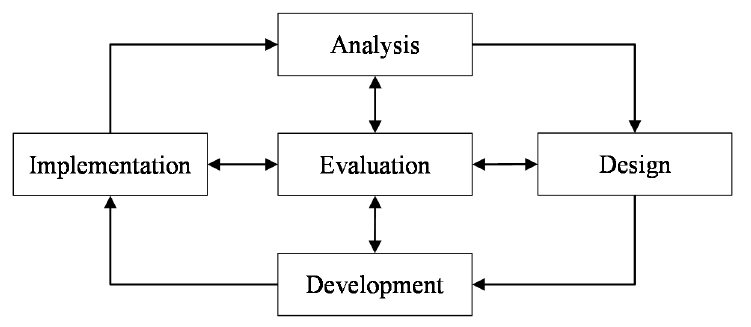
Figure 2. Analysis, design, development, implementation, and evaluation (ADDIE) model for the system development process.